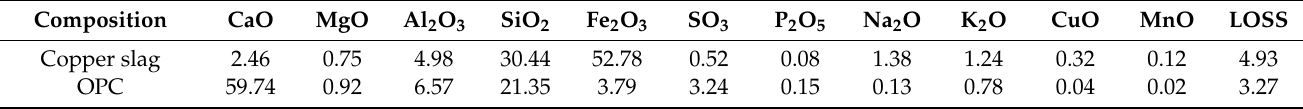
Table 1. Chemical composition of OPC and copper slag (wt/%).